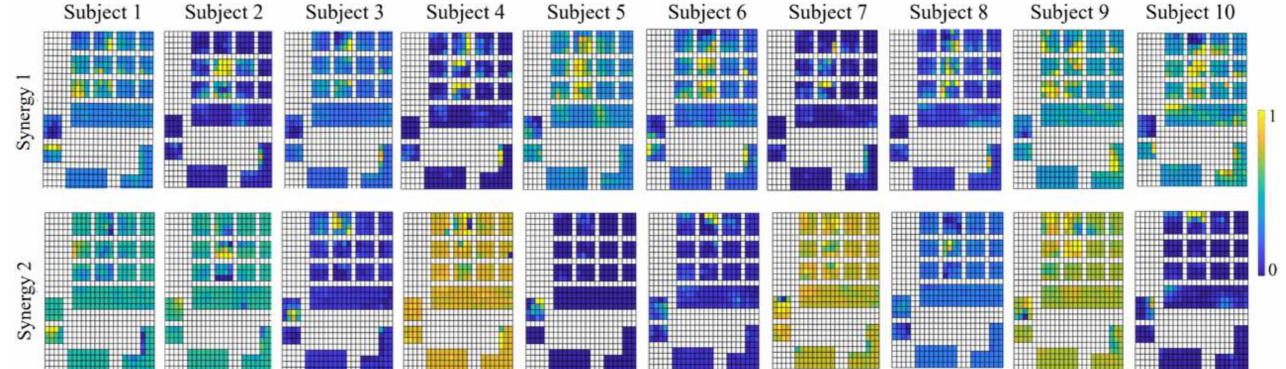
Figure 8. The first two dynamical synergies derived from digital force patterns (object weight 620 g) from all ten subjects. The dominant load force areas are concentrated on the middle finger and thumb. The first synergy carries a consistent force distribution among all the subjects, while the second synergy contains both common force information as well as individual variance. The color bar indicates the normalized scale of forces obtained from principal